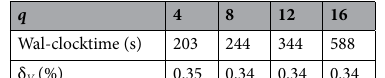
Table 2. Effects of q on the computation time and accuacy of P (